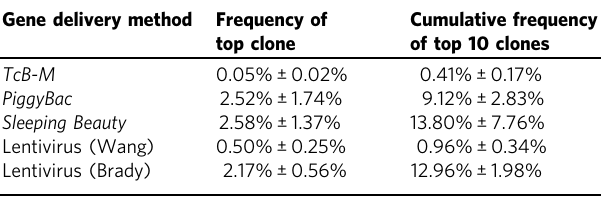
Table 1 Clonal outgrowth frequency of T cell clones.